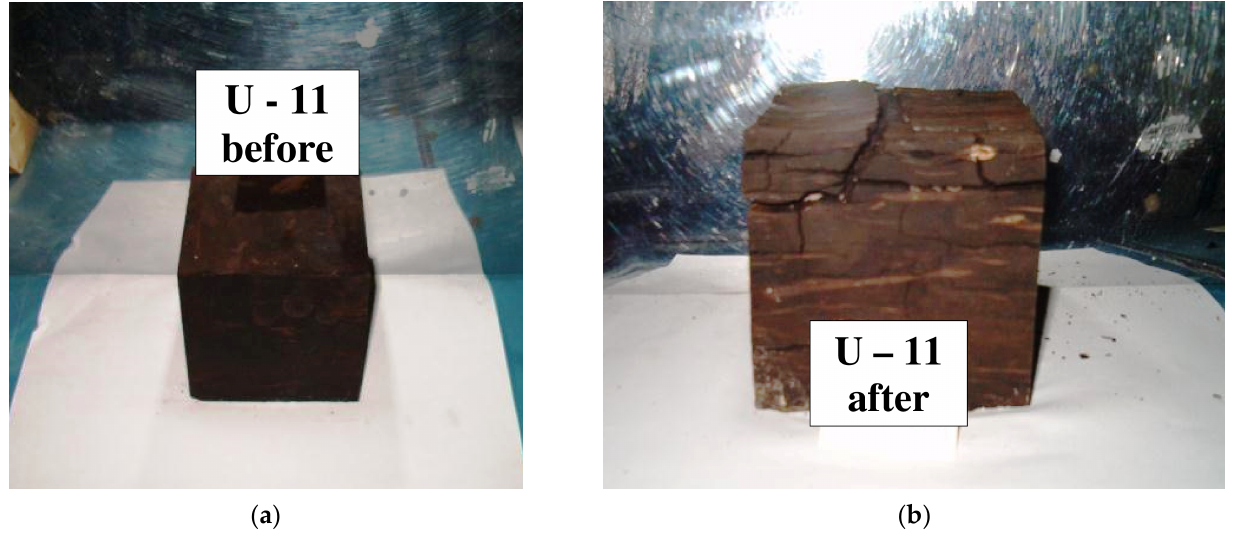
Figure 17. Sample for cutting resistance testing in underwater coal mining conditions ( a ) before testing and ( b ) after testing. Table 2. Results of cutting resistance tests for all defined confining pressures, σ 3.